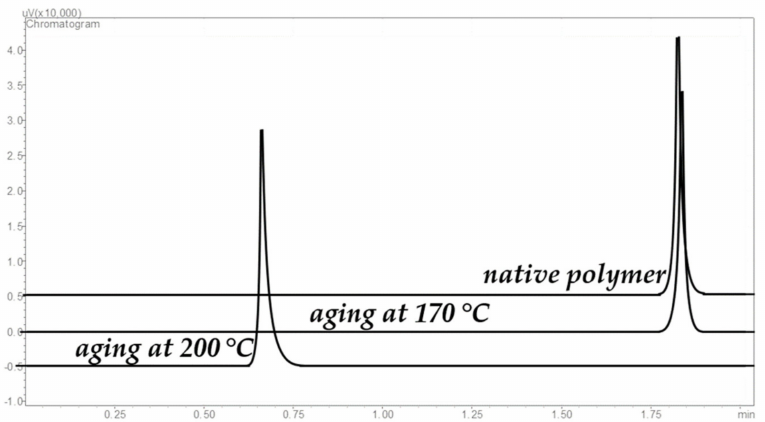
Figure 6. Changes in hexane retention on PTBSN stationary phase after thermal aging using method (2). Carrier gas helium, P i 70 kPa, column temperature 130 ◦ C, isotherm.